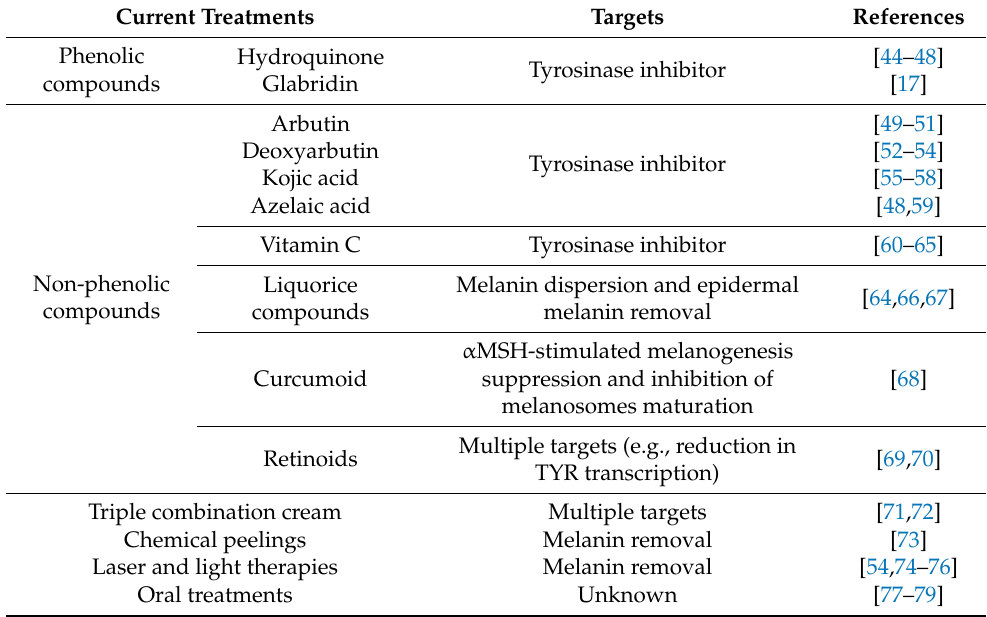
Table 2. Current treatments in